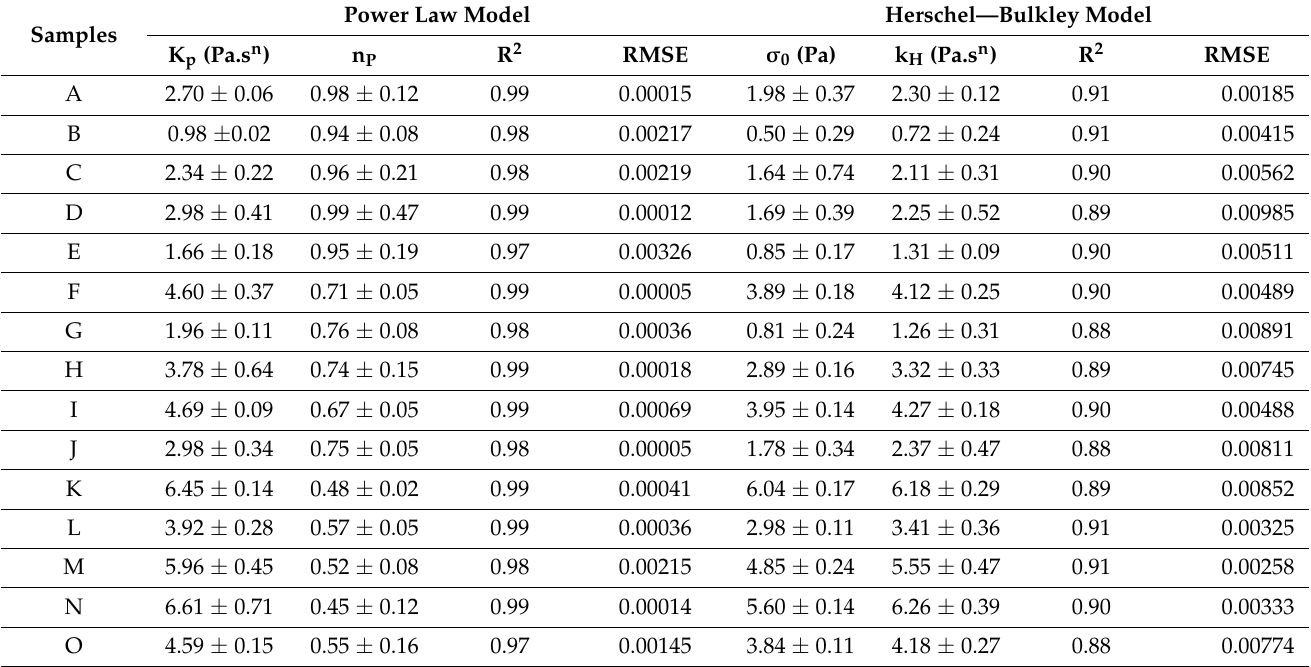
Table 3. The results of fitting data of emulsions containing two hydrocolloids (fenugreek galac- tomannan and xanthan gum) with the Carraeu model.